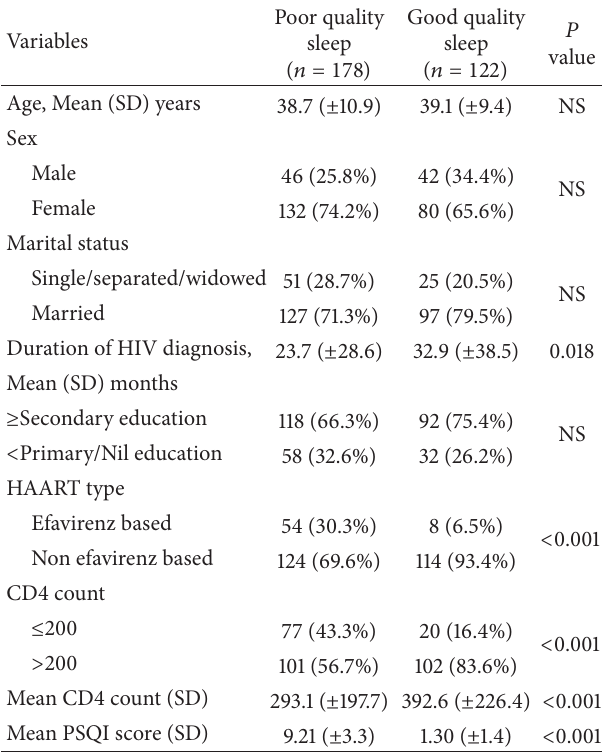
Table 3: Relationship of the significant correlates with sleep quality using multivariate logistic regression.